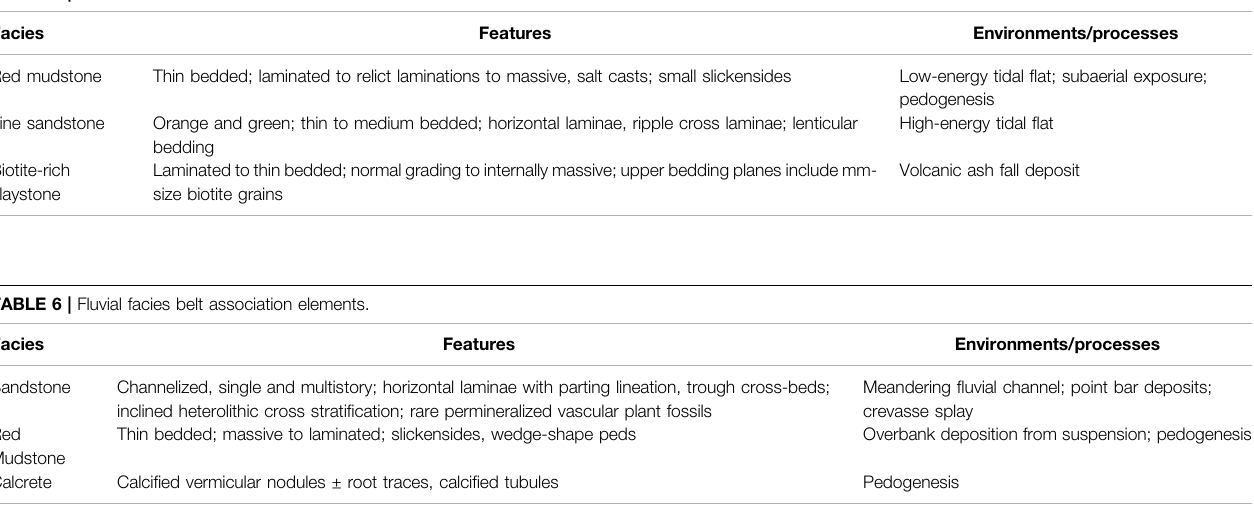
TABLE 5 | Mud/Sand- fl at facies.